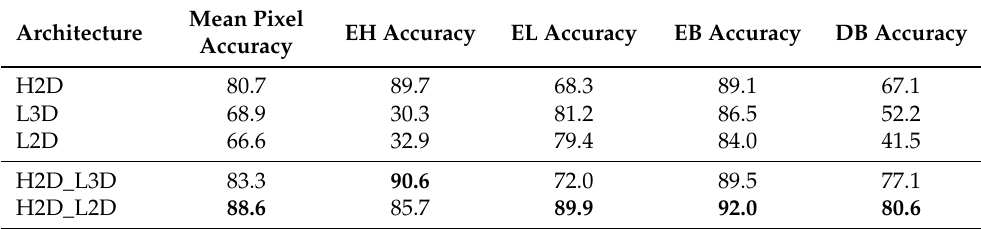
Table 4. Each model’s mean test set accuracy with respect to easier- and harder-to-classify sam- ples across both the hyperspectral and lidar modality. Highest mean accuracy per sample type is